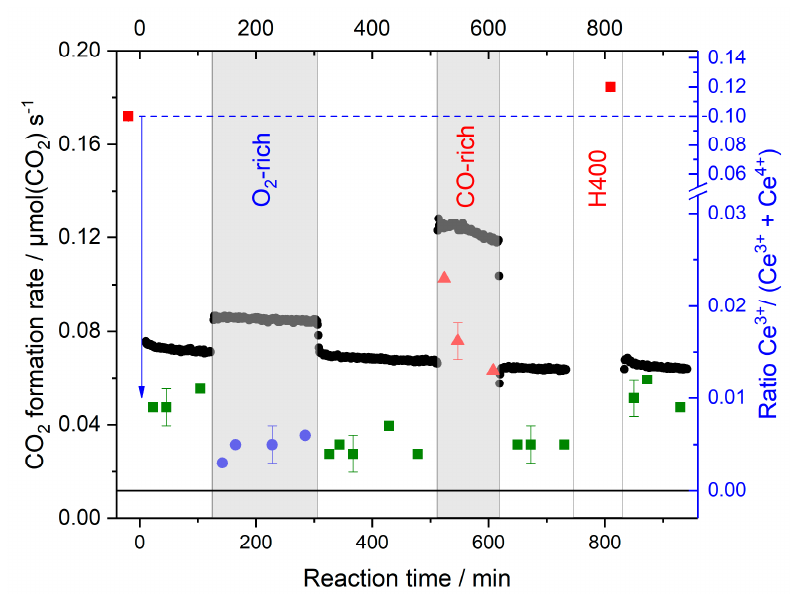
Figure 5. Formation rate during CO oxidation in di ff erent reaction atmospheres (standard, O 2 -rich, CO-rich) at 80 ◦ C on a Au / CeO 2 catalyst after reductive (H400) pretreatment in 10% H 2 in N 2 at 400 ◦ C (black circles) and the relative Ce 3 + content during time on stream as extracted from LCA analysis of operando X-ray absorption spectra recorded in fluorescence mode during reaction (blue, green, and red symbols). Representative error bars are shown for each sequence.